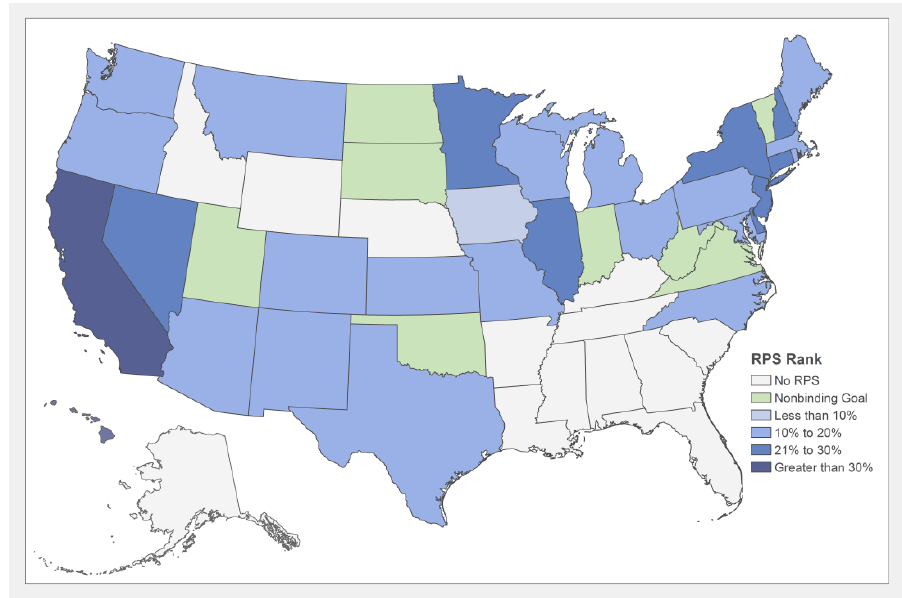
Figure 1. Renewable portfolio standards in the US by goal. Data from the Solar Energy Industry Association [26].